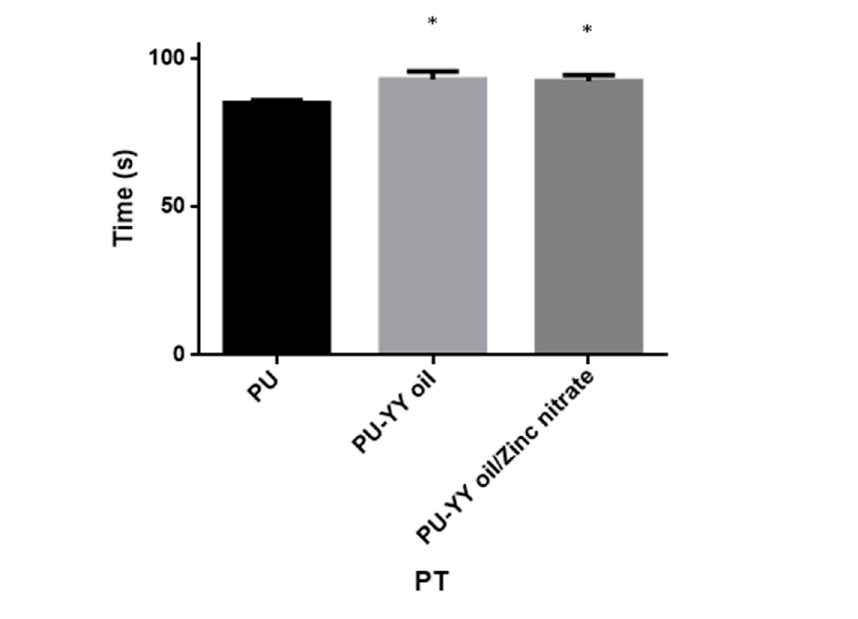
Figure 10. Prothrombin Time (PT) assay of PU, PU/YY and PU/YY/ZnNO 3.